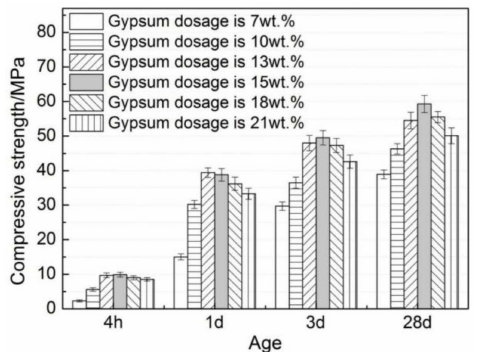
Figure 6. E ff ect of gypsum dosage on compressive strength of AMCSA